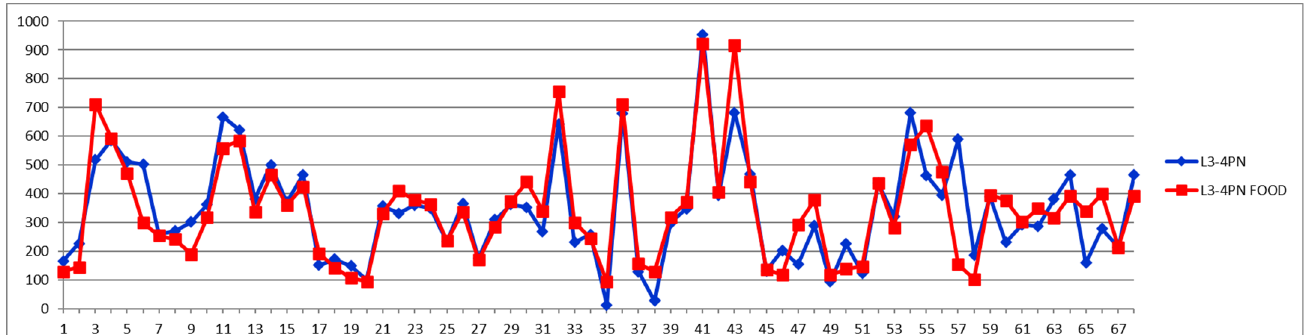
Figure 7. Medium LDL particle number (L3PN + L4PN) (nmol/L) in fasting (blue) and postprandial (red) status for control cases (1–29) and CVD cases (30–68).